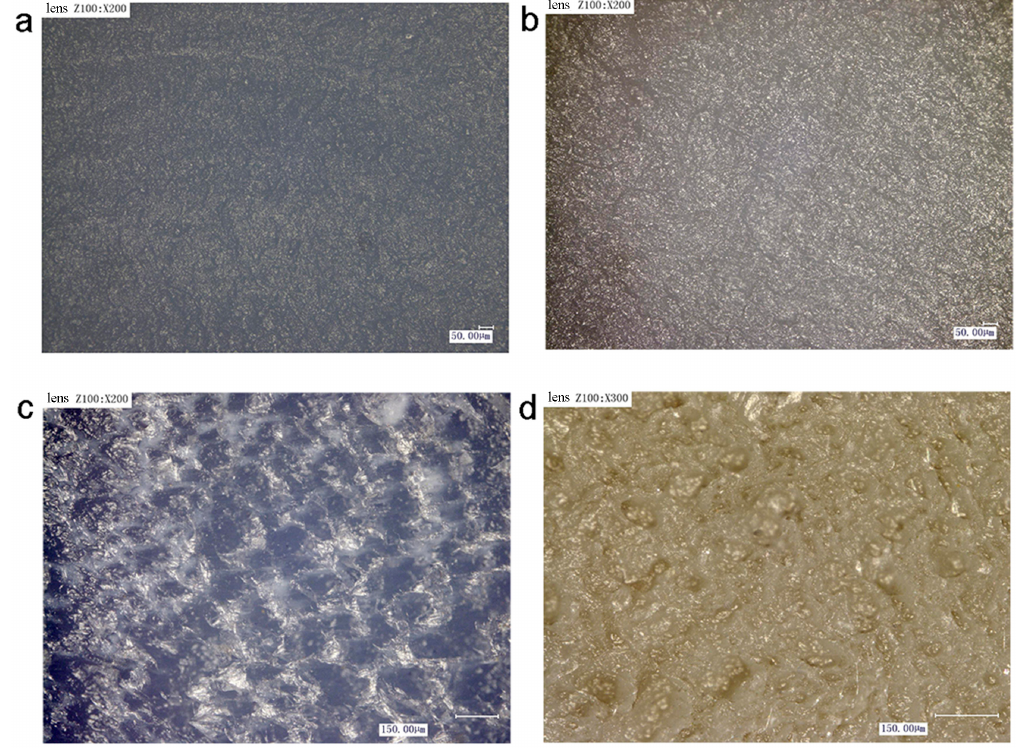
Figure 8. The micro morphology of welding area: ( a ) untreated PE; ( b ) untreated POM; ( c ) treated PE; ( d ) treated POM.